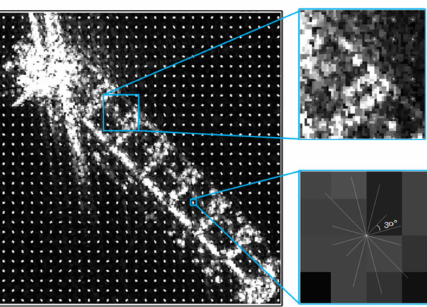
Figure 3. SAR ship HOG features. Here, two small regions are magnified for more intuitive visual observation of HOG